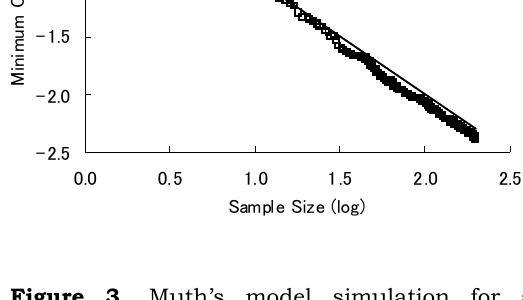
Figure 3. Muth’s model simulation for a production process with 100 operations Source: Takahashi (2001), Figure